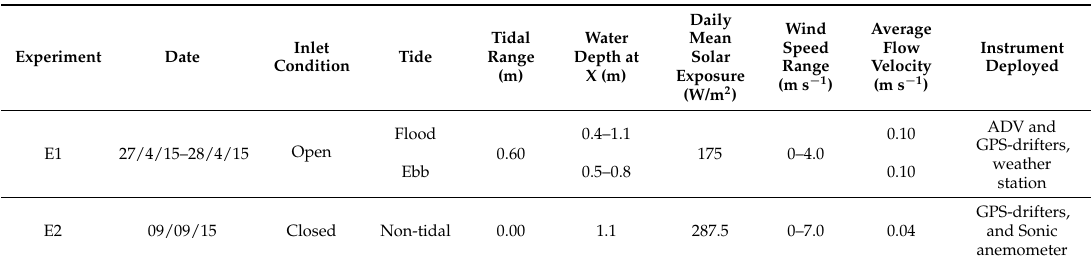
Table 1. Summary of the experimental conditions and instruments deployed at Currimundi Lake; flow velocity and wind speed were measured using ADV, weather station and sonic anemometer deployed at the Pontoon (Figure